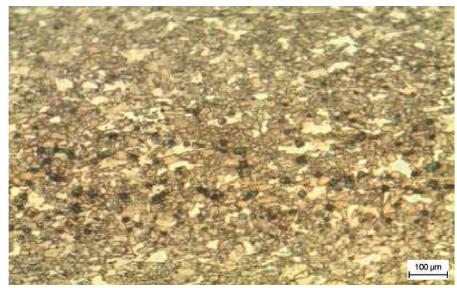
Figure 2: Microstructure of parent material (at 100x).